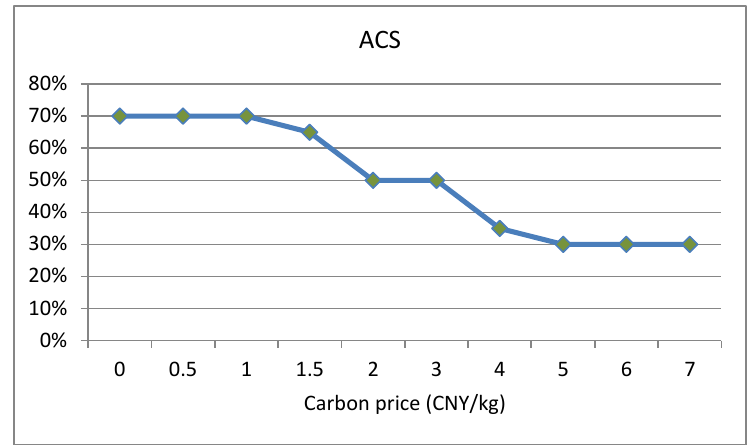
Figure 6. The changing trends of carbon emissions and total cost with the carbon price changes under sufficient carbon quota. Int. J. Environ. Res. Public Health 2019 , 16 , x